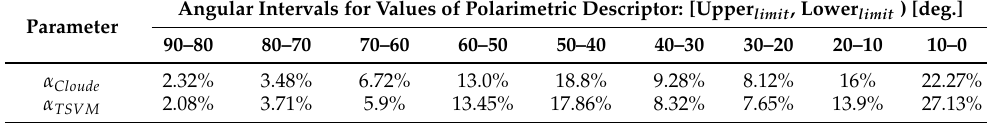
Table 7. Square plate. Percentage distribution of estimated values for the angular polarimetric descriptors, in intervals of 10 deg., between [0, 90] deg., for the selection of monostatic observation directions. Angular Intervals for Values of Polarimetric Descriptor: [Upper limit , Lower limit ) Parameter